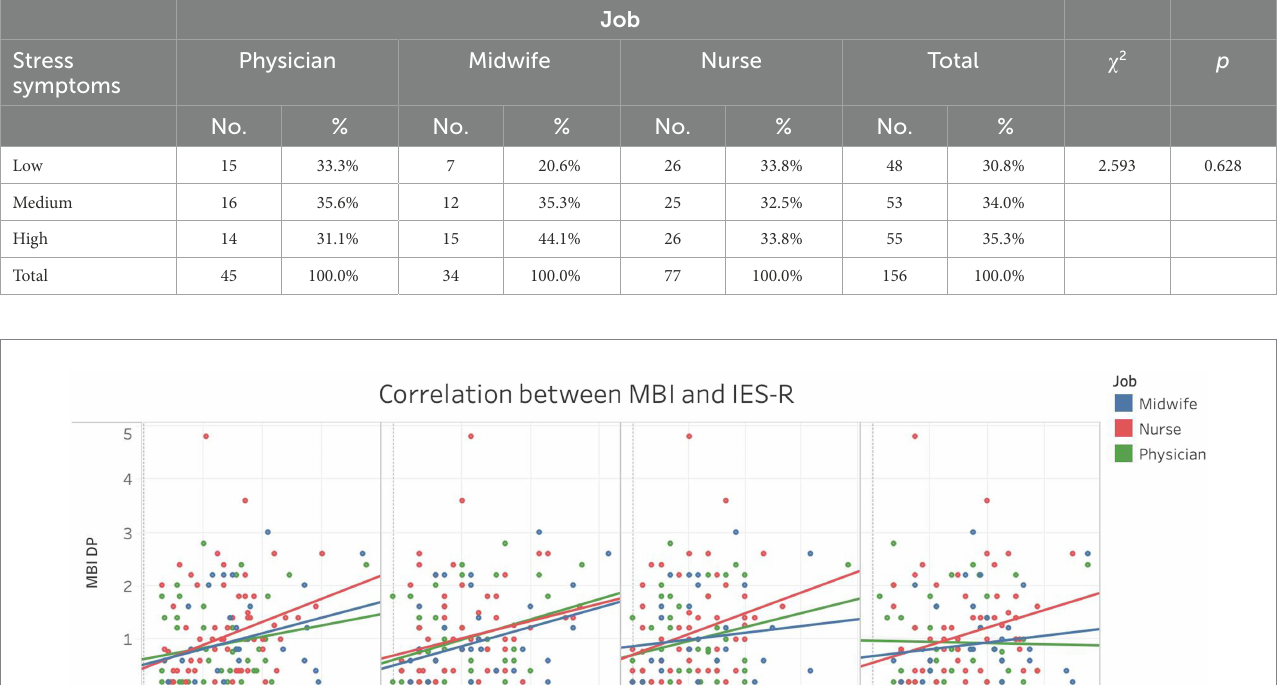
TABLE 5 Level of PTSD-like symptoms (measured by IES-R) according to different professions.